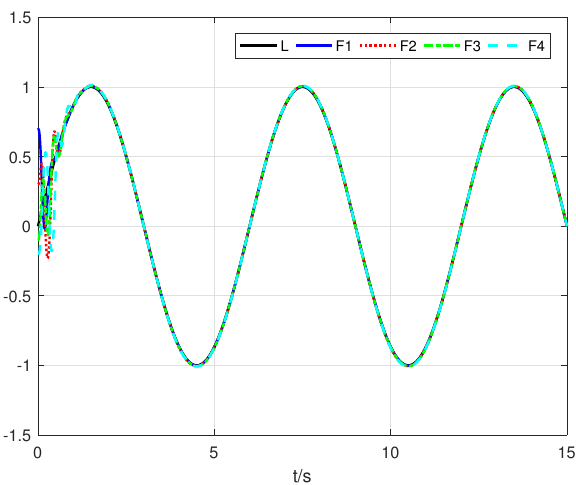
Figure 3. The trajectories of the follower output signals y i and leader signal r .